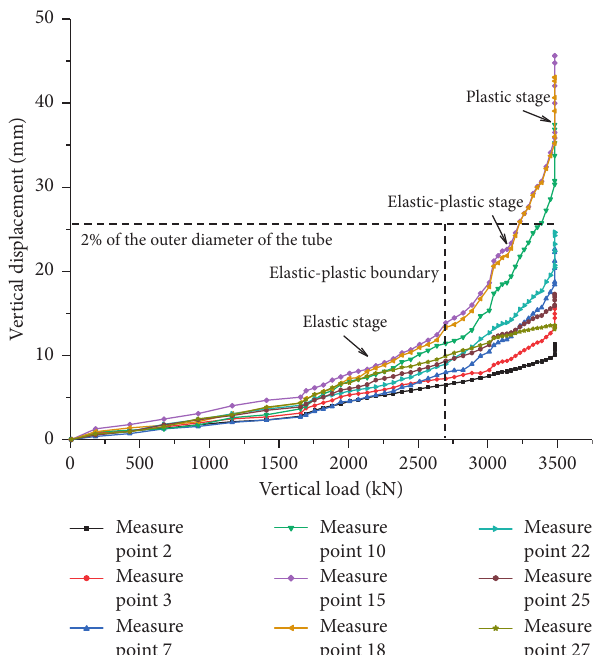
Figure 9: Change in the single-point displacement of each mea- suring point for different vertical